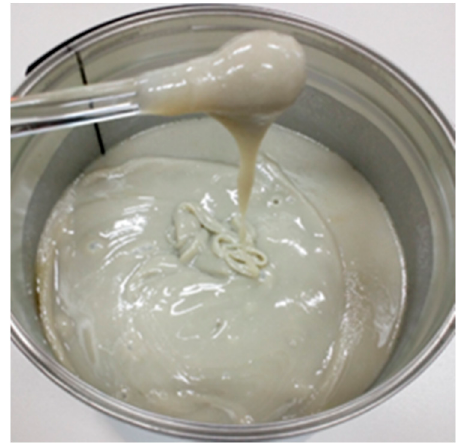
Figure 2. Glycolisate based on waste PET.